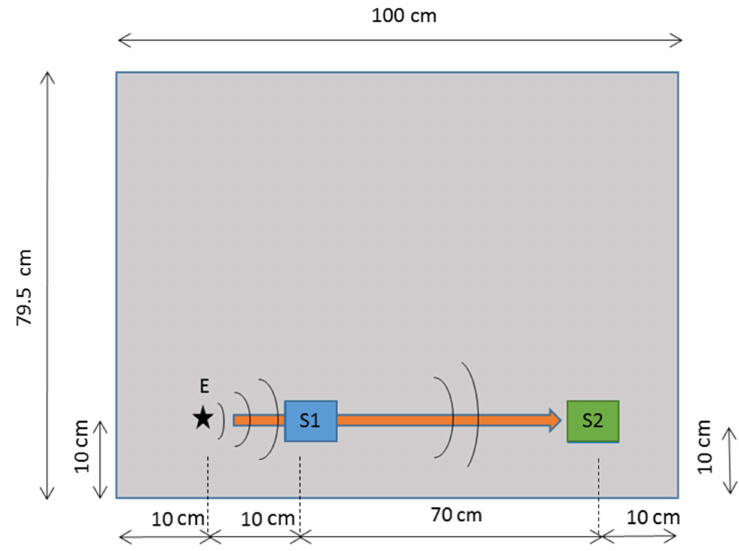
Figure 2. Measuring the experimental propagation velocity in the composite